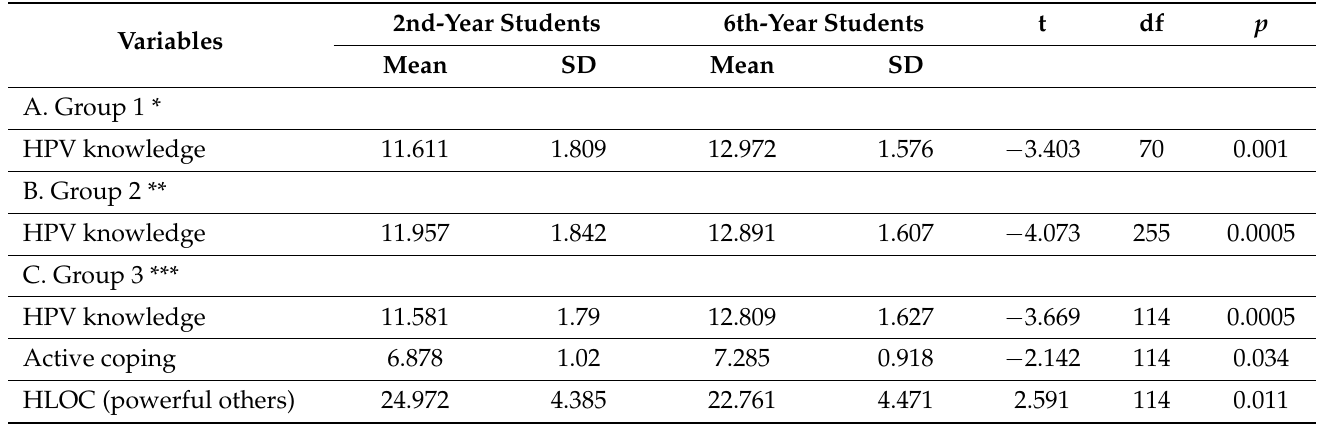
Table 5. Preclinical–clinical differences a